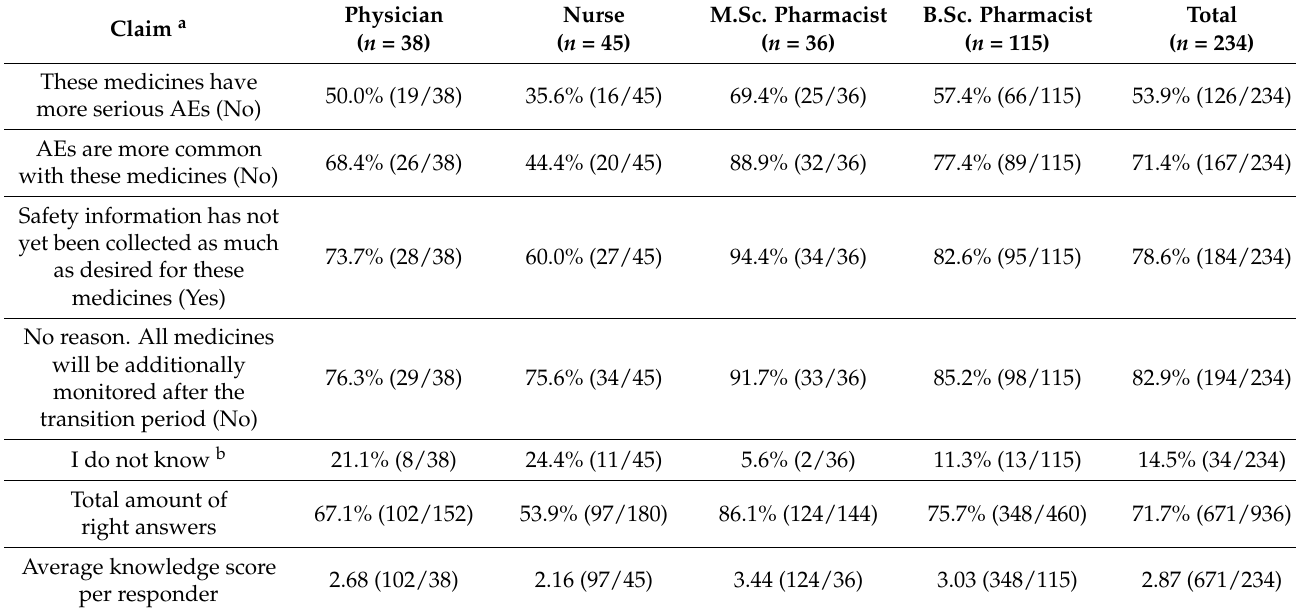
Table 3. Additional monitoring knowledge among Finnish HCPs: Why are some medicines additionally monitored? % correct, ( n / n ) correct answers/all